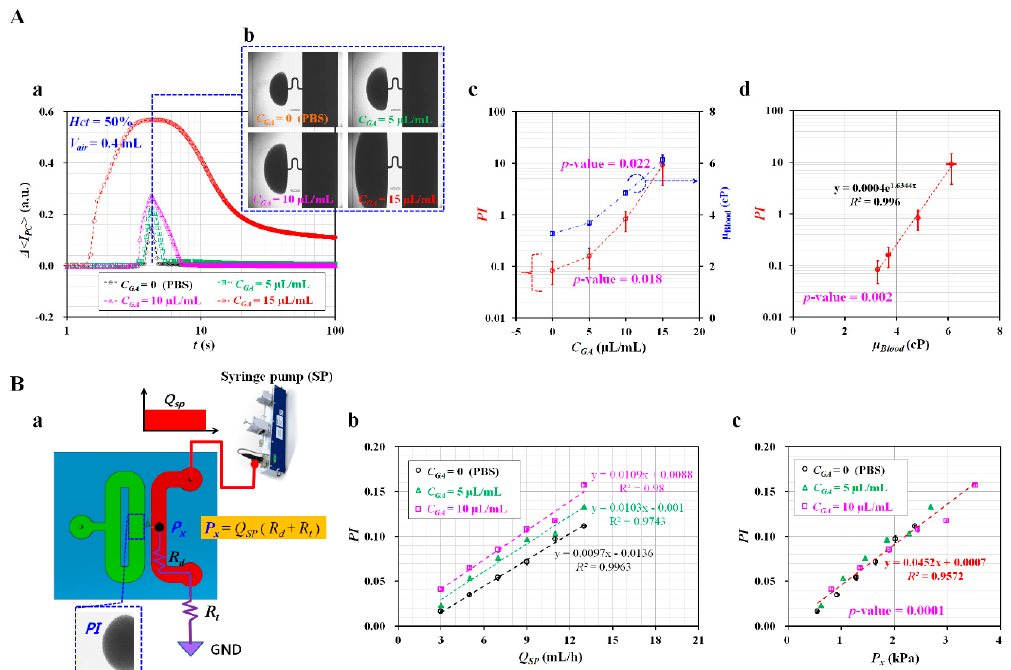
Figure 3. Quantitative evaluations of pressure for blood samples composed of glutaraldehyde (GA)-induced hardened RBCs. Here, the blood sample (haematocrit ( Hct ) = 50%) was consistently supplied into a microfluidic channel by operating the ACS at the same protocol (i.e., air suction = 0.4 mL, blood suction = 0.4 mL, and air compression = 0.3 mL). ( A ) Pressure measurement for various blood samples composed of RBCs hardened with various concentrations of GA solution. ( a ) Temporal variations of ∆ < I PC > with respect to various concentrations of GA solution ( C GA = 0, 5, 10, and 15 µ L / mL). ( b ) Microscopic images captured at the time when ∆ < I PC > had the highest value depending on C GA . ( c ) Variations of pressure index ( PI ) and blood viscosity ( µ Blood ) with respect to C GA . ( d ) Relationship between PI and µ Blood . ( B ) Relationship between PI and pressure at junction ( P x ) in microfluidic channel. ( a ) Schematic diagram of experimental setup. GND (i.e., Ground) means zero value of gauge pressure (i.e., P = 0). ( b ) Variations of PI with respect to Q SP and C GA . ( c ) Linear relationship between PI and P x .